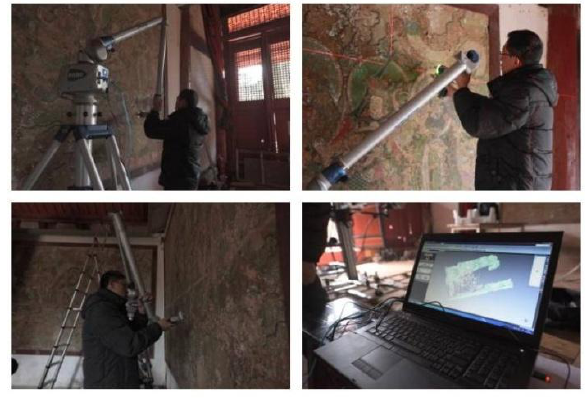
Figure 22 use arm of a laser scanner to develop a good 3D model of the mural